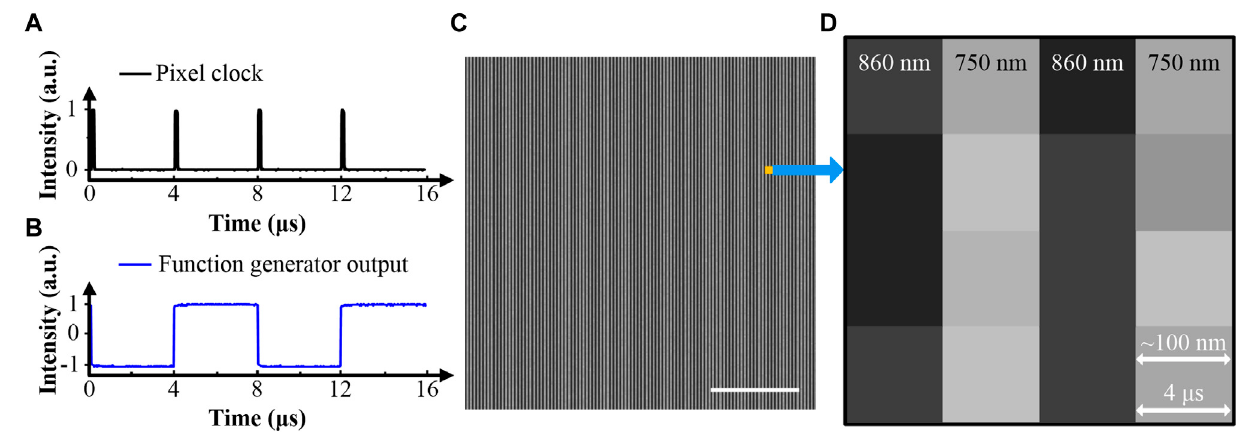
FIGURE 2 | (A) The pixel clock from the microscope. (B) The pulse train from the function generator. (C) Demonstration of TPF imaging using pixel-to-pixel wavelength-switching, 4 μ s/pixel, 200 × 200 pixels. The stripe pattern image is acquired from FAD in a buffered solution. (D) Zoomed-in view of (C) , 4 × 4 pixels. Signals gained with different excitation wavelengths are displayed in different columns. The scale bar is 5 μ